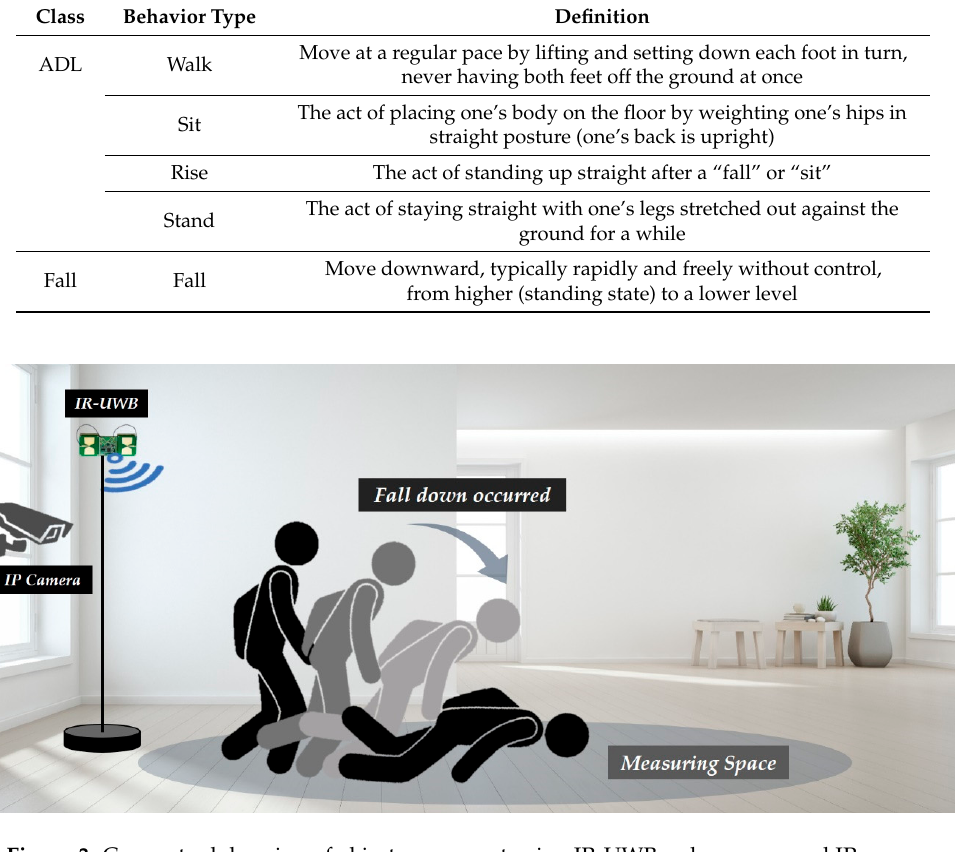
Figure 3. Conceptual drawing of object movement using IR-UWB radar sensor and IP